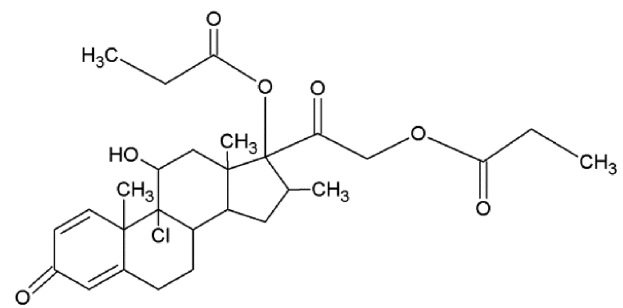
FIGURE 1 - Chemical structure of beclomethasone